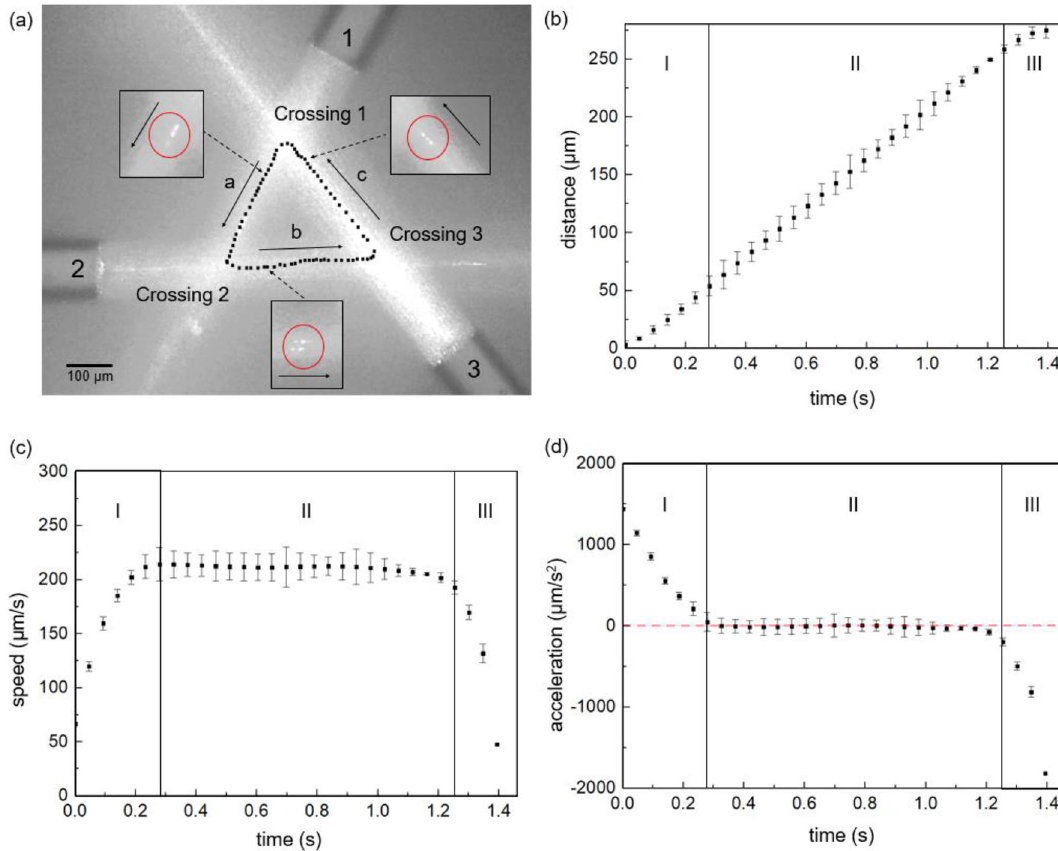
Figure 4. ( a ) The motion of a single polystyrene microparticle circulating along an optical triangle formed by crossing three Bessel-like beams in the aqueous solution. Three beams from BBGs labeled as 1, 2, and 3 formed a triangle (~ 60° angle at the crossings) with three sides labeled as ‘a’, ‘b’, and ‘c’. The black dots along the optical triangle represent the positions of the bead’s center measured at a constant time interval of 50 ms ( b ) The distance of the bead along the side ‘a’ as a function of time. Here the distance was measured from the Crossing 1 to the bead center. ( c ) The speed of the bead and ( d ) the acceleration in the corresponding range of ( b ). The particle motion in ( b )–( d ) was categorized by three segments; the segment I—‘Exit’ from the initial ‘Crossing 1’, the segment II—‘Transport’ along the side ‘a’, and the segment III—‘Entry’ to the next ‘Crossing